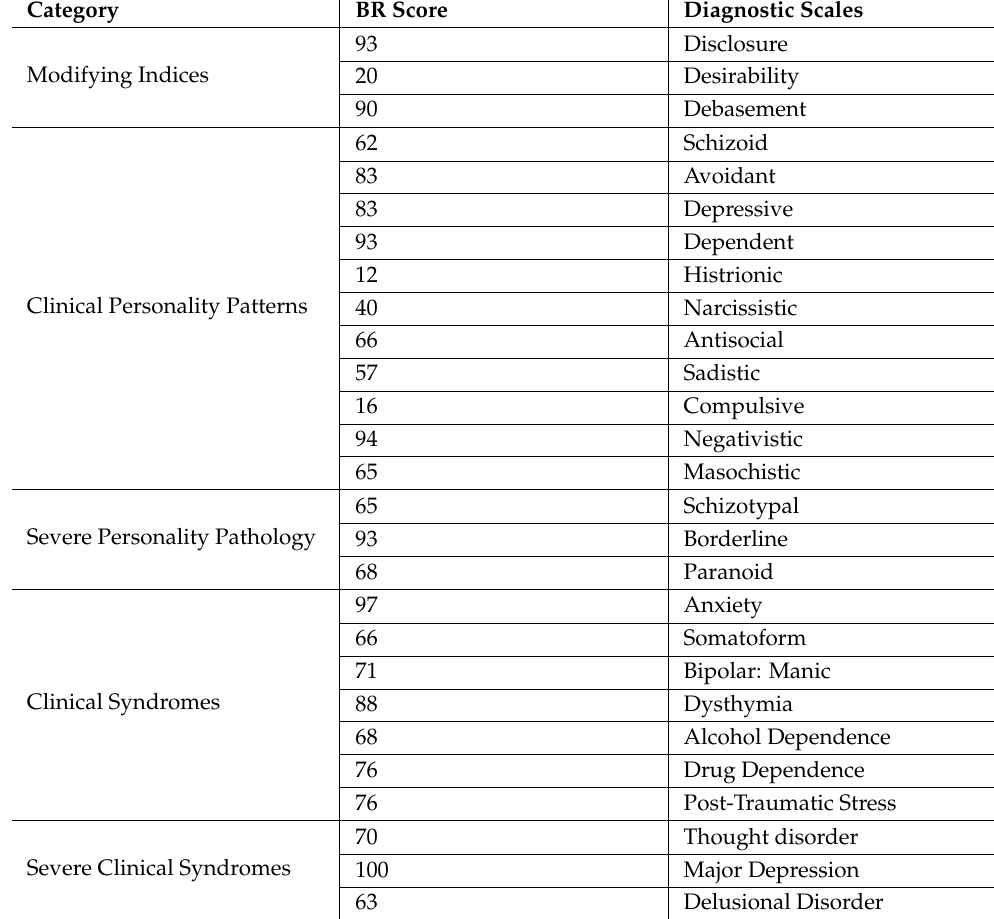
Table 6. Sample MCMI-III score report.